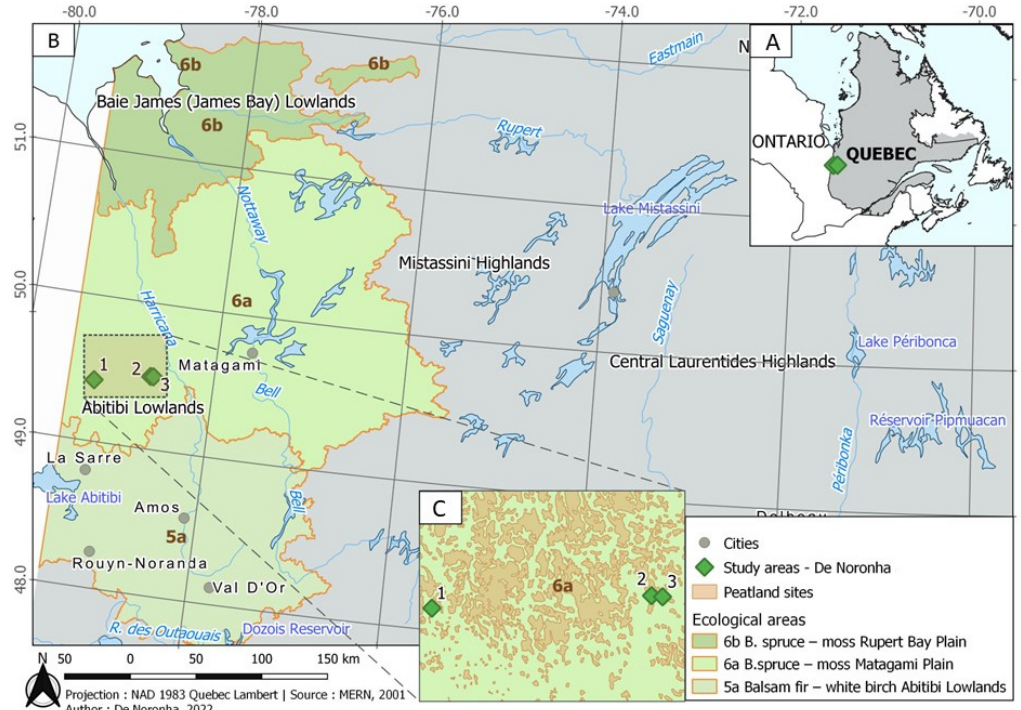
Figure 1. Study areas: ( A ). Location of the growing substrates for the greenhouse experiment in Eastern Canada. ( B ). Location of substrate sources in ecological regions in the boreal Black spruce forest of western Quebec (1: − 79.249, 49.419; 2: 78.665, 49.497; 3: − 78.655, 49.498). ( C ). Three distinct areas with young stands treated by pre-commercial thinning and susceptible to the paludification